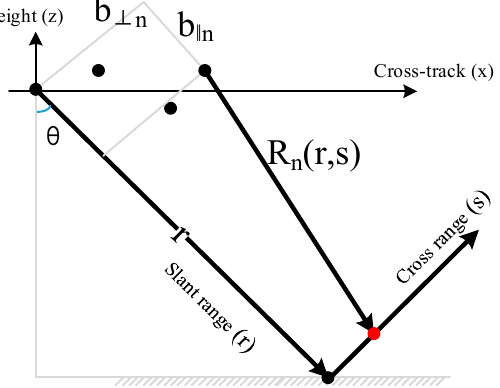
Figure 2. Geometry in the zero Doppler plane.